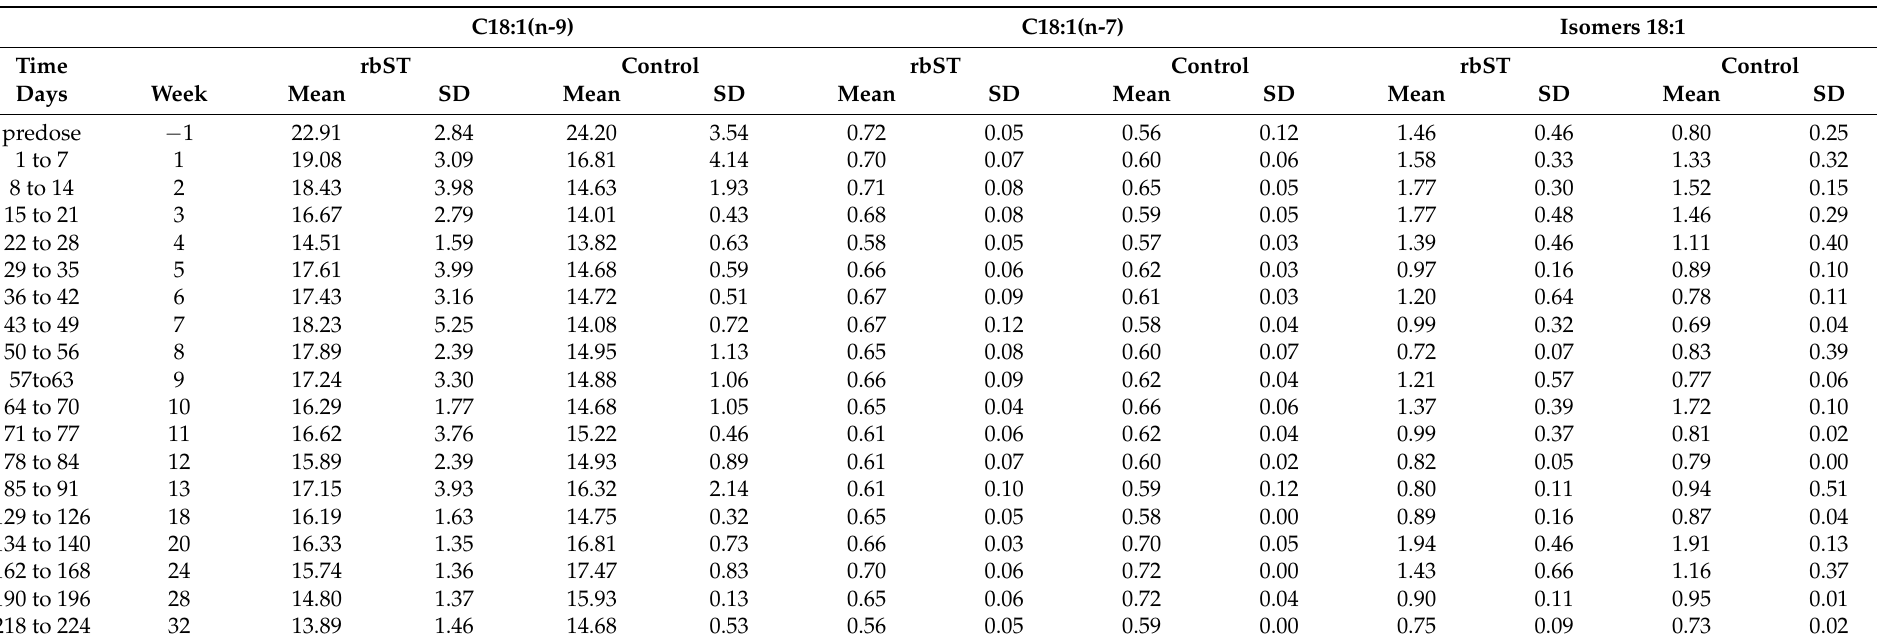
Table 5. Monounsaturated fatty acids with 18 carbons in milk (% w / w of total fatty acids) obtained from cows treated with recombinant bovine somatotropin (rbST) ( n = 6) and from control animals ( n = 3) at different time points selected over the course of 37 weeks (8 injections of Lactotropina manufactured by Elanco, Eli Lilly,